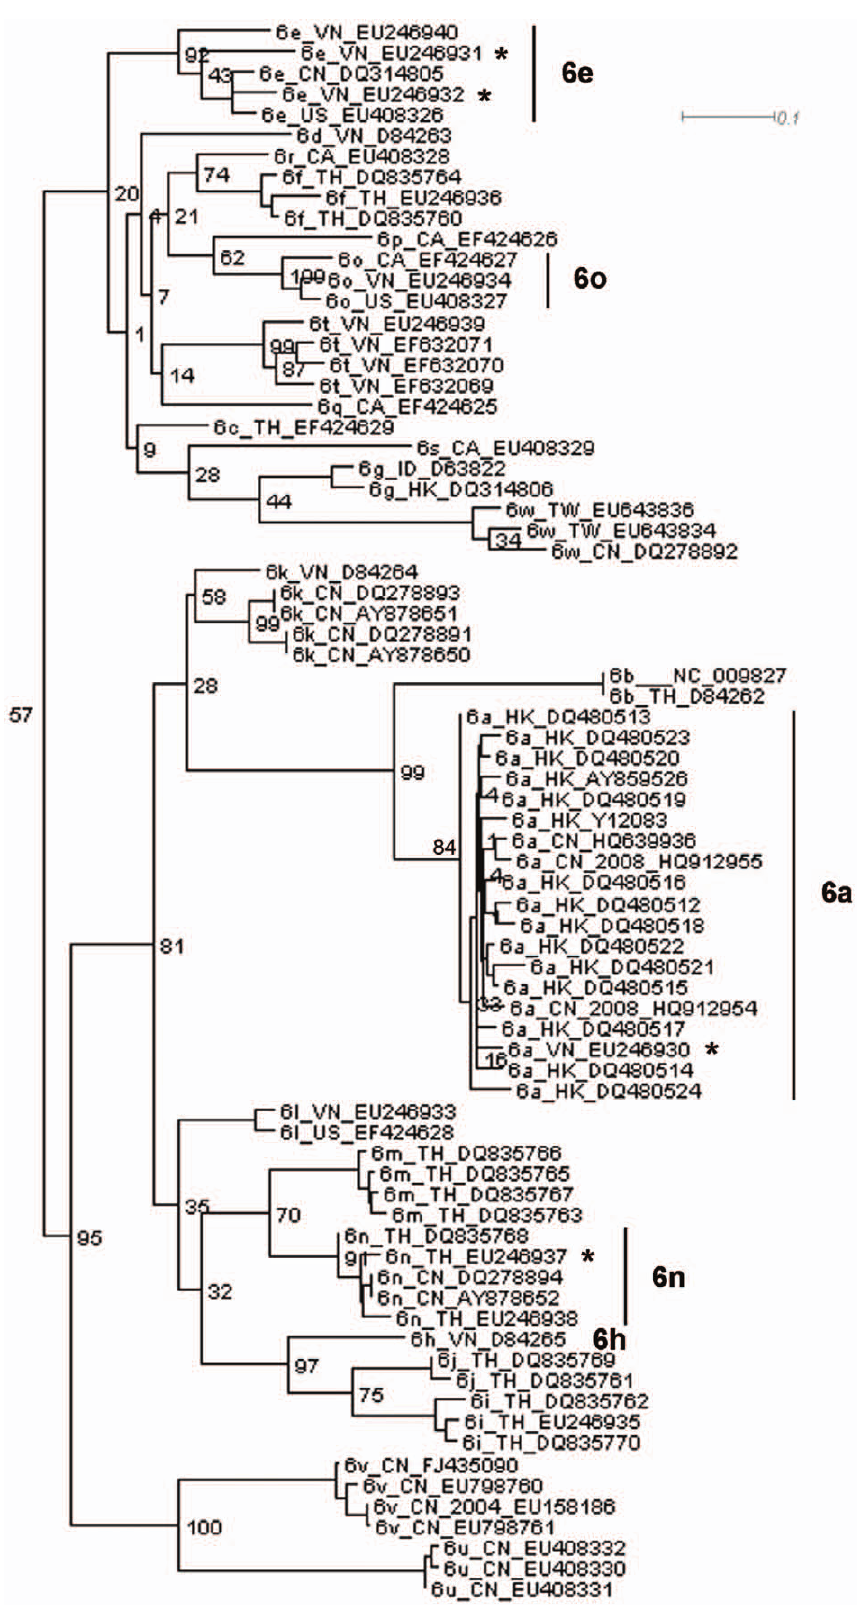
Figure 1. The genotype 6 part of the phylogenetic tree constructed using the first 600 bp of the alignment.